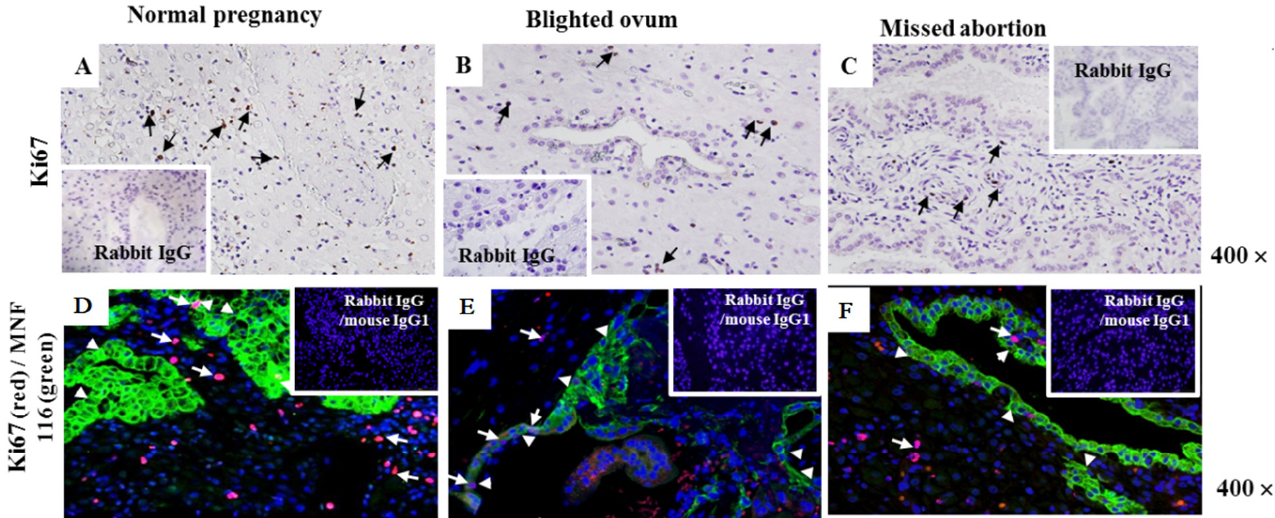
Figure 2. Ki-67 and Ki-67/cytokeratin co-expression in the decidua of normal pregnancy ( A , D ), blighted ovum ( B , E ), and missed abortion ( C , F ). Immunohistology ( A – C ) shows single labeling with mouse anti-Ki-67 mAb or mouse IgG1 (inserts) using indirect immunoperoxidase staining. Ki-67 + cells are stained brown (black arrows). Double immunofluorescent labeling of Ki-67 and Cytokeratin in NP ( D ), BO ( E ), and MA ( F ). Ki-67 fluoresces red, and Cytokeratin fluoresces green. The nuclei are stained blue by DAPI. Purple fluorescence visualizes the merge of red and blue color (white arrows), while green fluorescence (white arrowheads). The inserts represent isotype-matched control. Ten samples were in each group. Magnification: 400×.